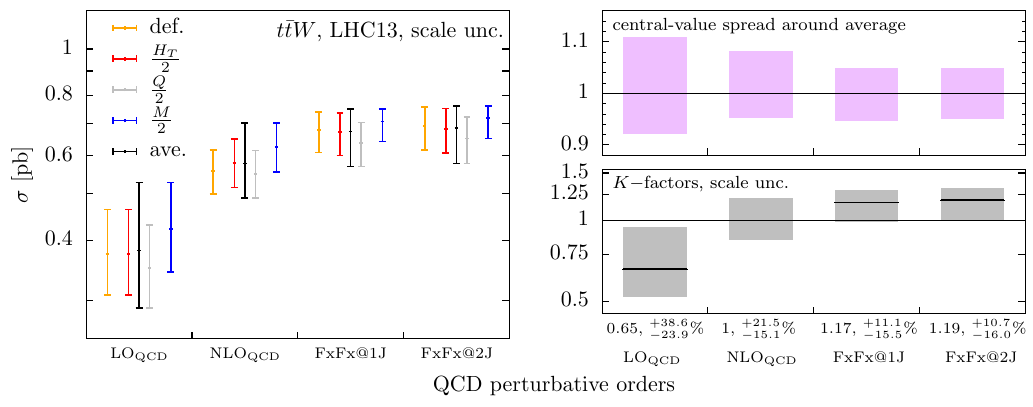
Figure 5 . Cross sections of various QCD perturbative orders of t ¯ tW production (left plot). Percent deviation of the different central values with respect to their average (upper right ratio plot). K - factors of the averaged central values with the combined scale uncertainties (lower right ratio